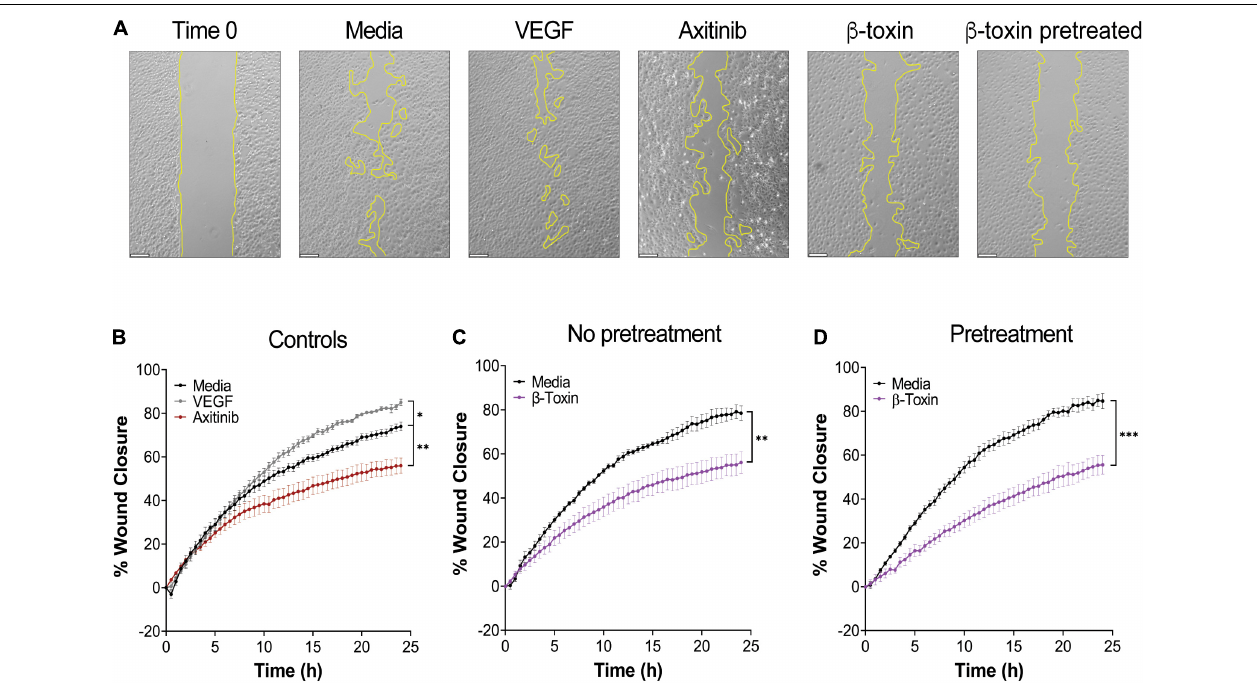
FIGURE 2 | β -toxin inhibits wound healing. Time course analysis of iHAECs grown to confluency in silicone inserts that create uniform gaps upon removal and treated with either VEGF (10 ng mL − 1 ), axitinib (10 µ M), or β -toxin (50 µ g mL − 1 ) for 24 h. Images captured every 30 min. (A) Phase-contrast microscopy at Time 0 (representative image) and at 24 h for all conditions tested. Scale bar = 200 µ m. (B) iHAECs treated with VEGF or axitinib. (C) iHAECs treated with β -toxin. (D) iHAECs pretreated overnight with β -toxin prior to gap formation and thereafter. (B–D) All results are mean ± SEM of five independent experiments with four replicates each. ∗ p < 0.0332, ∗∗ p < 0.0021, ∗∗∗ p < 0.002; two-way repeated measures ANOVA with Tukey’s multiple comparisons